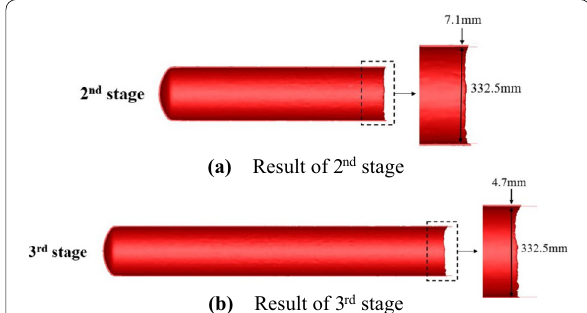
Figure 18 FEA results of 2 nd and 3 rd stages without defecting